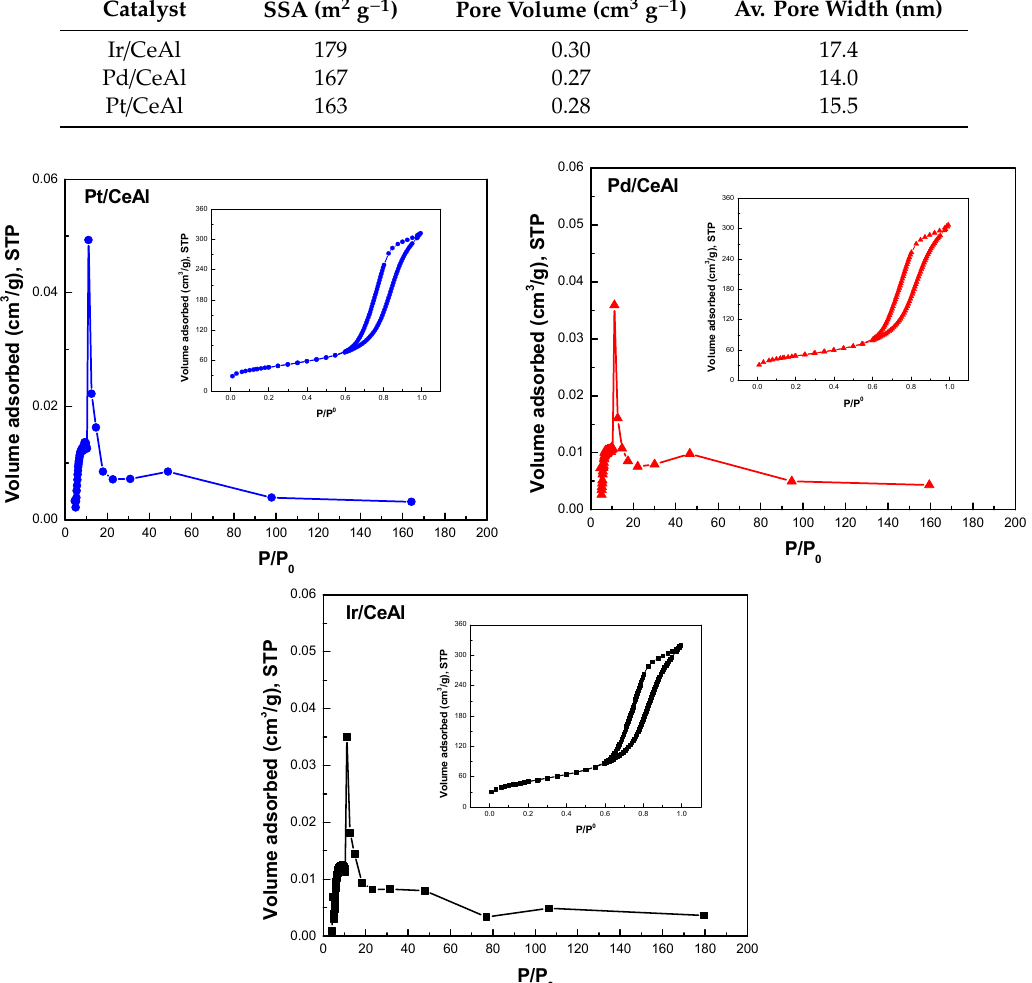
Figure 1. Pore size distribution and N 2 adsorption–desorption isotherms ( inset ) of the calcined Pt/CeAl, Pd/CeAl and Ir/CeAl catalysts.